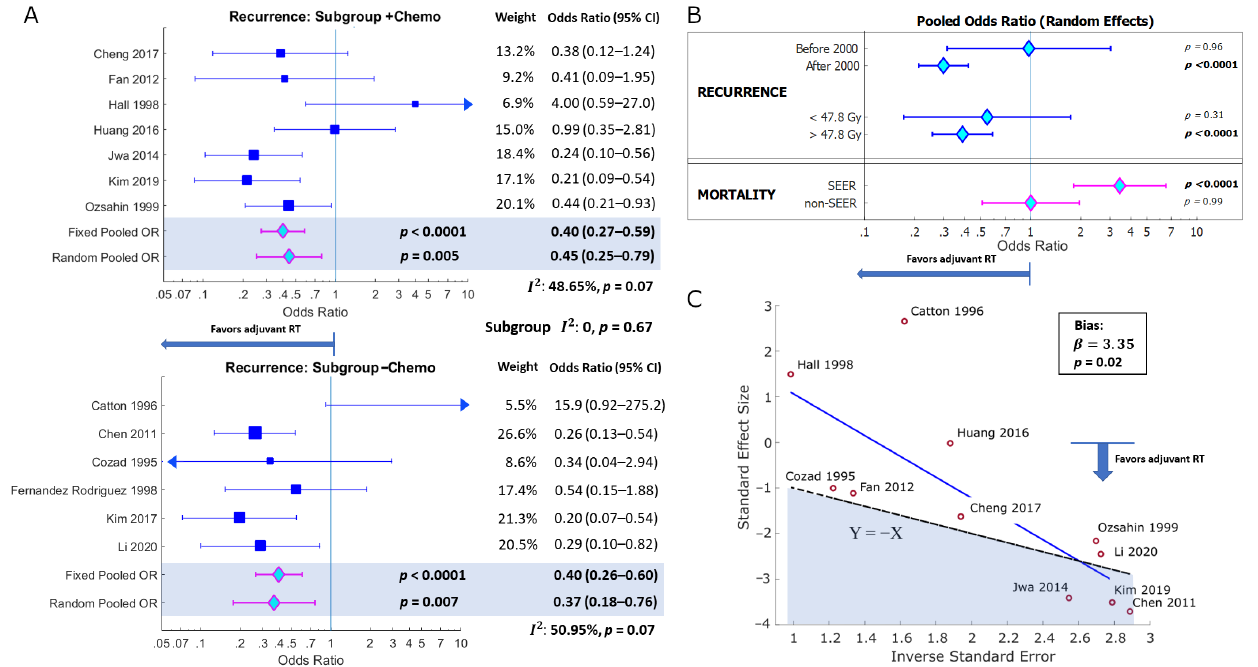
Figure 4. Subgroup analysis and small-study effects. ( A ) Forest plot for subgroup analysis of adjuvant radiotherapy with at least some patients receiving systemic chemotherapy (+Chemo) and those receiving radiotherapy alone ( − Chemo). ( B ) Subgroup analyses of recurrence risk (top) for studies before or after the year 2000; (middle) studies delivering more or less than the median dose of 47.8 Gy for adjuvant RT, and (bottom) composite mortality (i.e., combining studies reporting 3- or 5-year OS) by SEER or non-SEER study subgroups. ( C ) Radial plot of results of Harbord’s Test. Studies with high variance are on the left-hand side of the plot. The bias term ( β ) refers to the Y-intercept of the regression line (solid blue). Unbiased studies should be distributed symmetrically about |Y| = |X| (segmented black line), but a small-study bias is